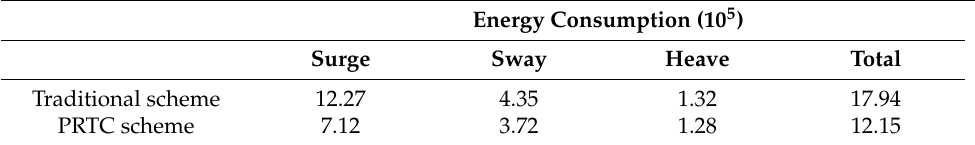
Table 2. Performance of the PRTC scheme and traditional scheme in terms of energy consumption.